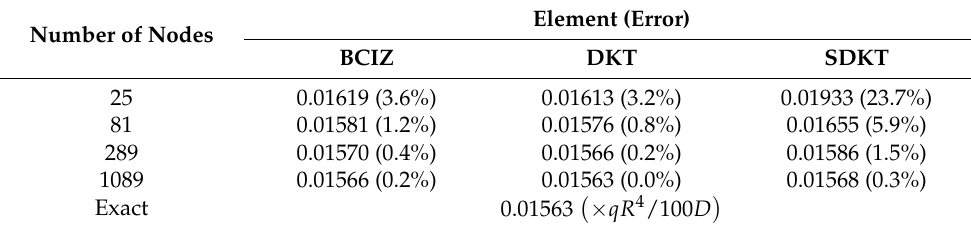
Figure 11. Mesh of one quarter of a clamped circular plate (81 nodes). Table 6. Central deflection for a clamped circular plate under uniform load.